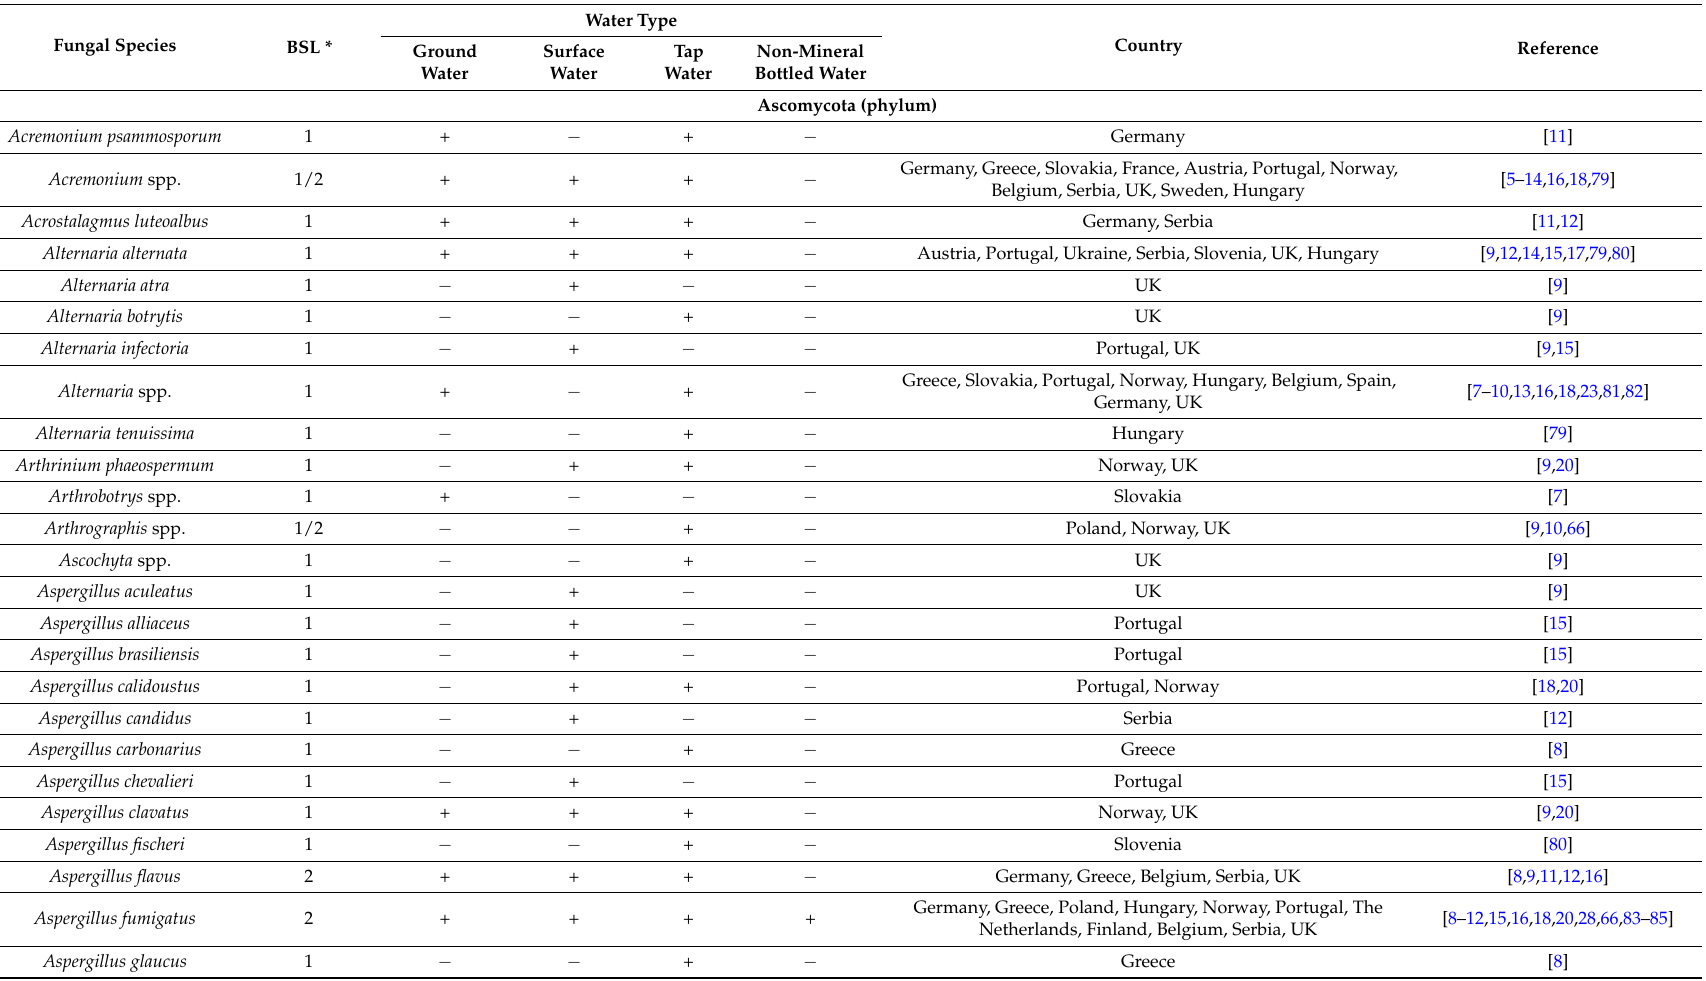
Table 1. Fungal genera and species isolated from groundwater, surface water, tap water and non-mineral bottled water reported in studies conducted in Europe during the last 30